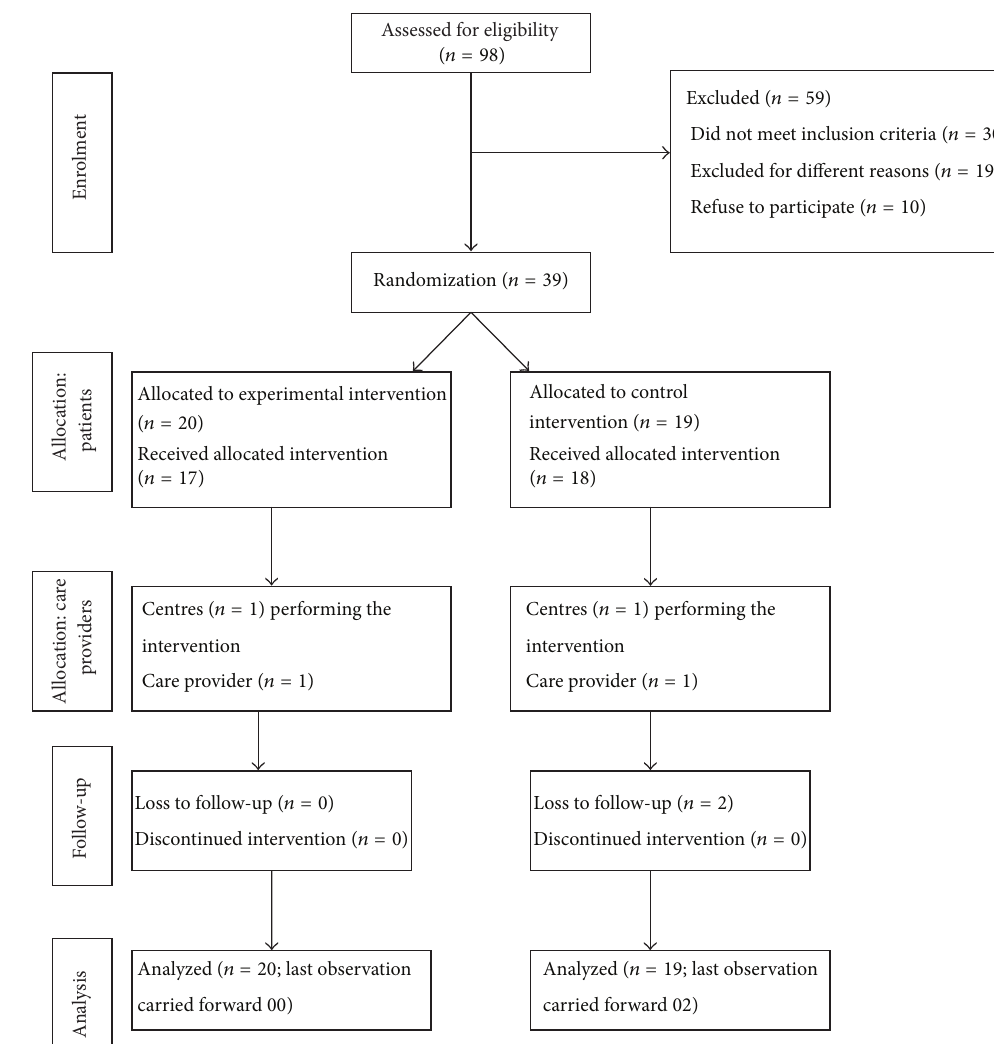
Figure 1: Consort diagram showing the flow of participants during the